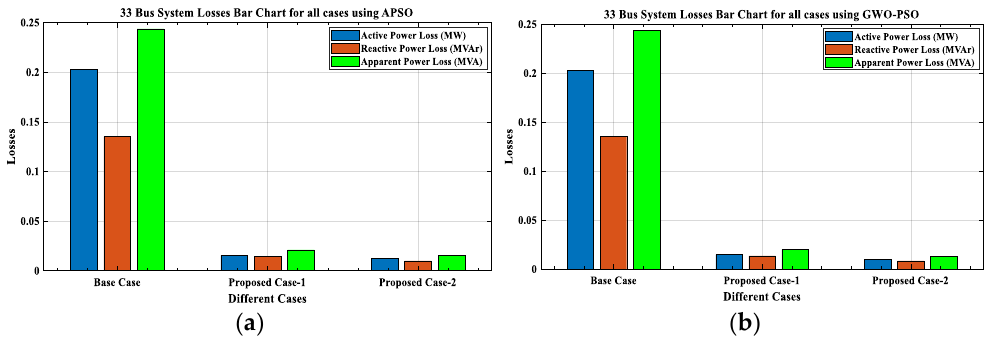
Figure 14. Cumulative bar representation of P Loss , Q Loss , and S Loss for all cases of 33-bus RDN; ( a ) APSO, ( b ) GWO-PSO.